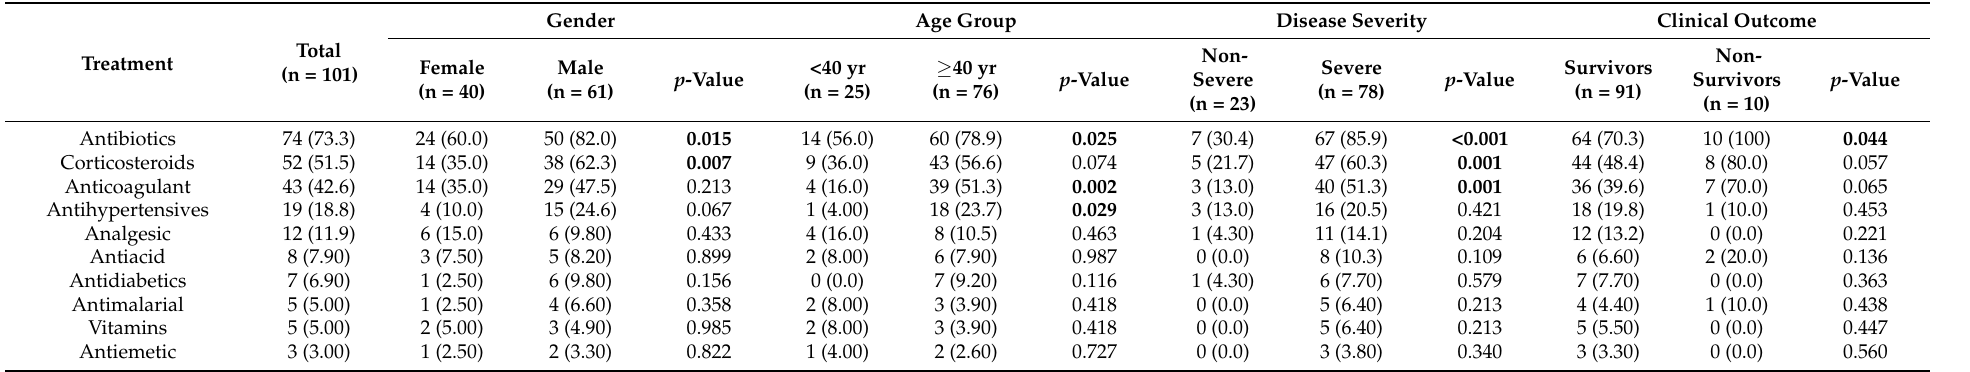
Table 3. Treatments related to clinical outcomes among COVID-19 patients in Luanda,